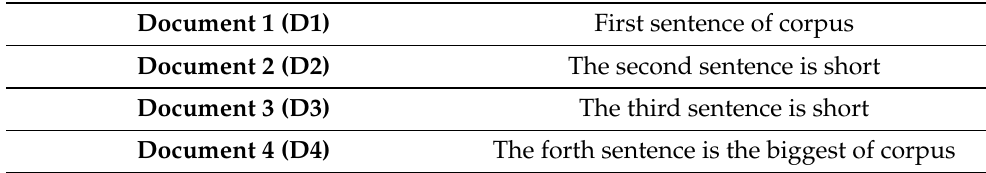
Table 4. Sample corpus. A toy example for vectorization techniques.